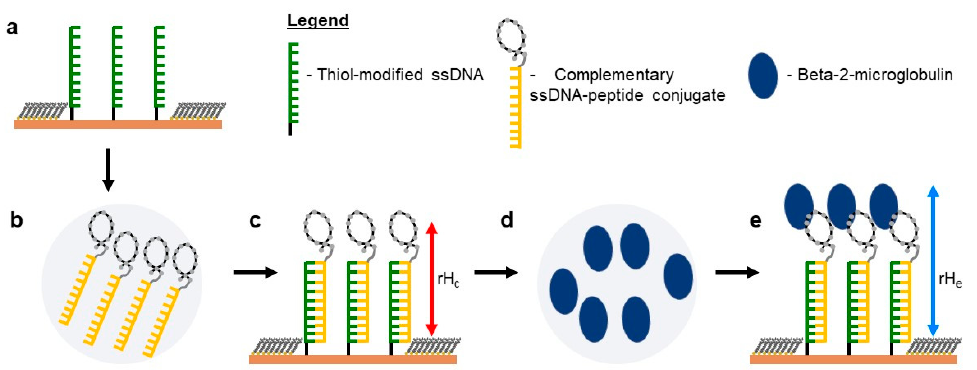
Figure 1. Step-by-step immobilization of dsDNA–peptide conjugate via DNA-directed immobilization (DDI) and atomic force microscopy (AFM) tip-induced nanografting. ( a ) Laterally confined thiol-modified ssDNA molecules surrounded with a bioresistant top-oligo-ethylene glycol (TOEG) monolayer. ( b ) A solution of complementary ssDNA–peptide conjugate. ( c ) The outcome of ( a ) treated with ( b ) with a measured relative height rHc (highlighted by a red arrow). ( d ) A solution of Beta-2-microglobulin. ( e ) The outcome of ( c ) treated with ( d ) with a relative height rHe (highlighted by a blue arrow). This cartoon representation does not reflect the real alignment of the molecules within the nanopatch.